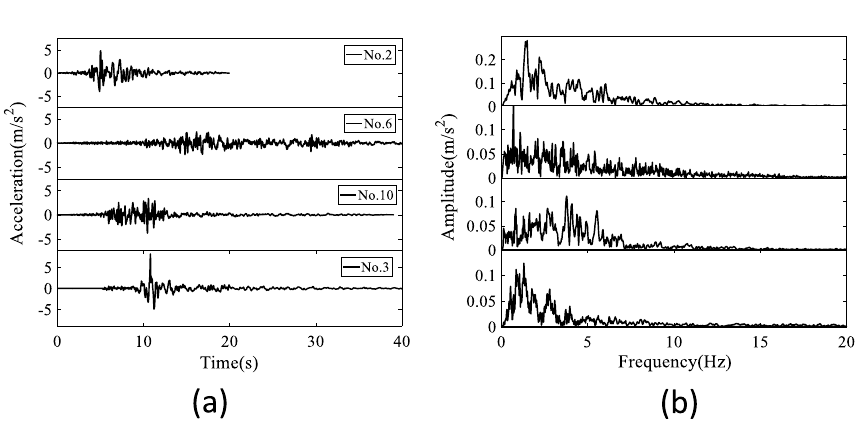
Fig. 18 Ground motion records: a time-domain; and b